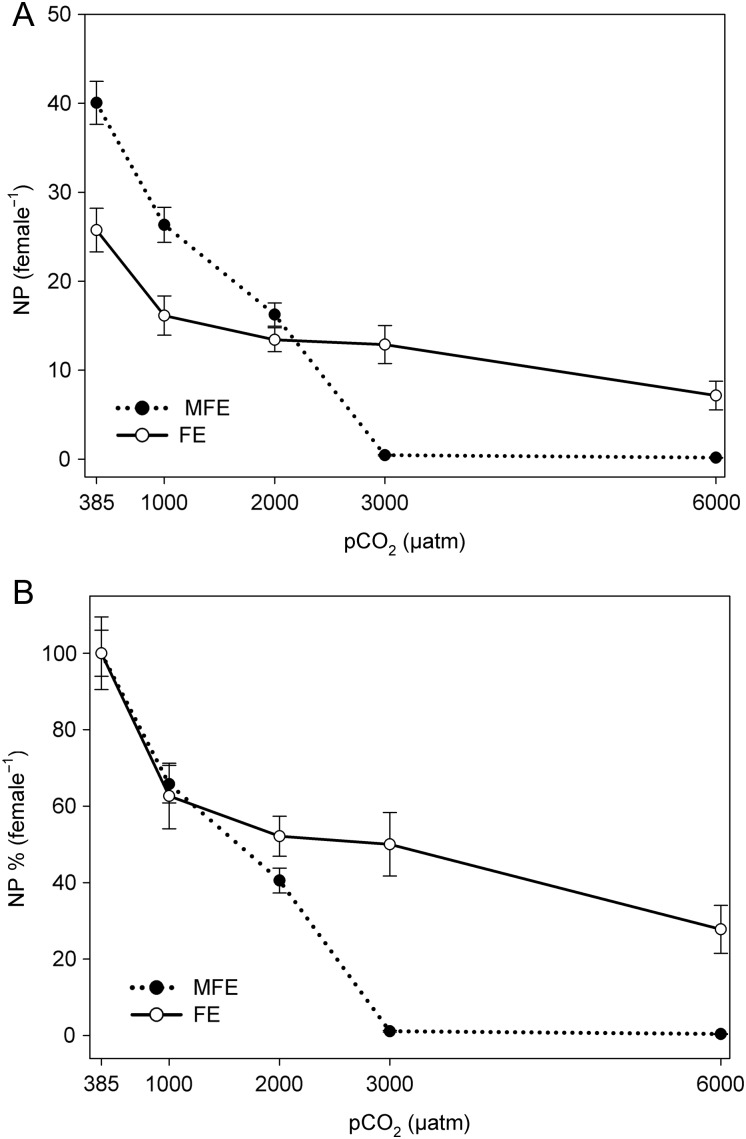
Nauplii production (mean ± 1 SE) of Acartia tonsa exposed to five different pCO2 levels with different parental exposures: (A) nauplii production (mean ± 1 SE) and (B) production normalized (i.e. NPnorm) against individual treatment controls at extant pCO2. MFE, combined male and female exposure to the pCO2 level; FE, sole female exposure to the pCO2 level.